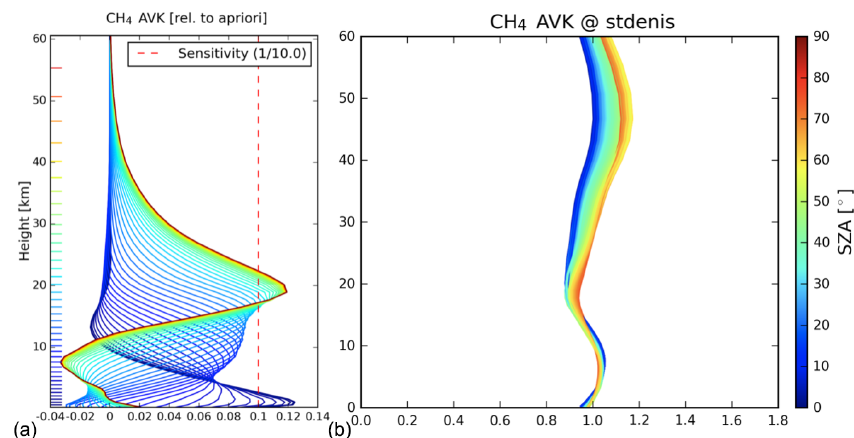
Figure 4. (a) A typical CH 4 averaging kernel matrix of the SFIT4NIR retrieval with the SZA of 63 ◦ at St Denis, in units of the mole fraction profile with respect to the a priori. (b) CH 4 column-averaging kernels (in unit of 1; applying for the partial column profile) with different solar zenith